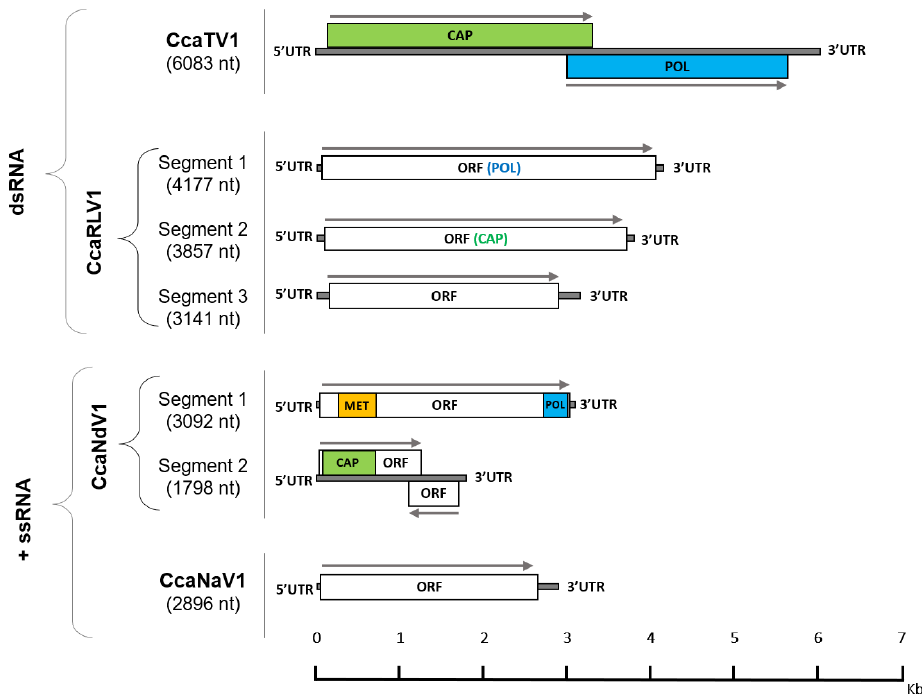
Figure 1. Putative genome organization of the four newly described viruses in medfly. Each genome is drawn proportionally to its length. White boxes represent open reading frames (ORFs) encoding viral proteins of an unknown function while colored regions represent ORFs encoding RNA-dependent RNA polymerase (POL, blue), capsid-protein (CAP, green), or methyltransferase (MET, yellow). The grey arrows displayed with the ORFs represent their orientation. Ceratitis capitata reo-like virus 1 (CcaRLV1) and Ceratitis capitata nodavirus 1 (CcaNdV1) harbor a segmented RNA genome, as shown for other viruses within their viral families.